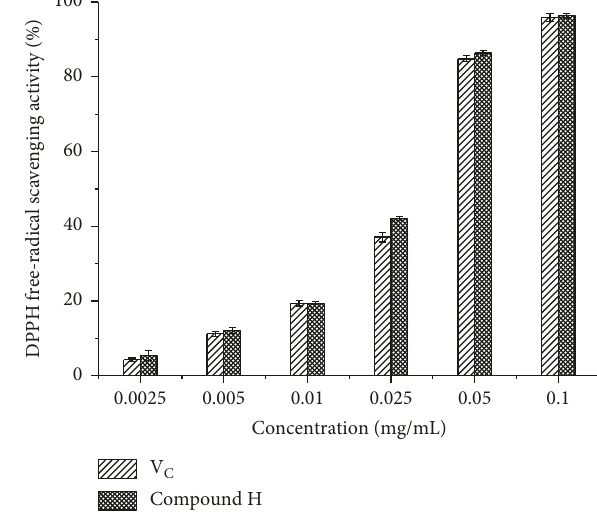
Figure 2: DPPH-scavenging activity of crude ME, V extraction fractions extracted from ME.